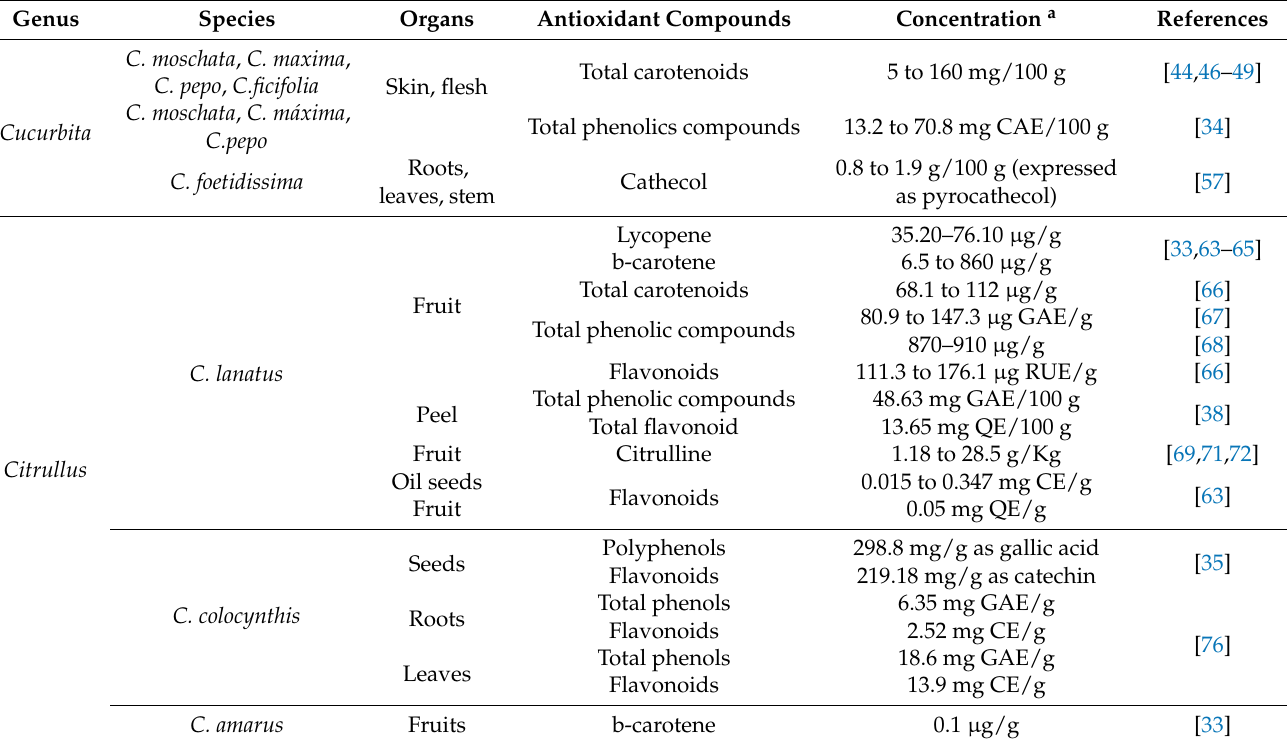
Table 1. Antioxidant compound range content in cucurbit